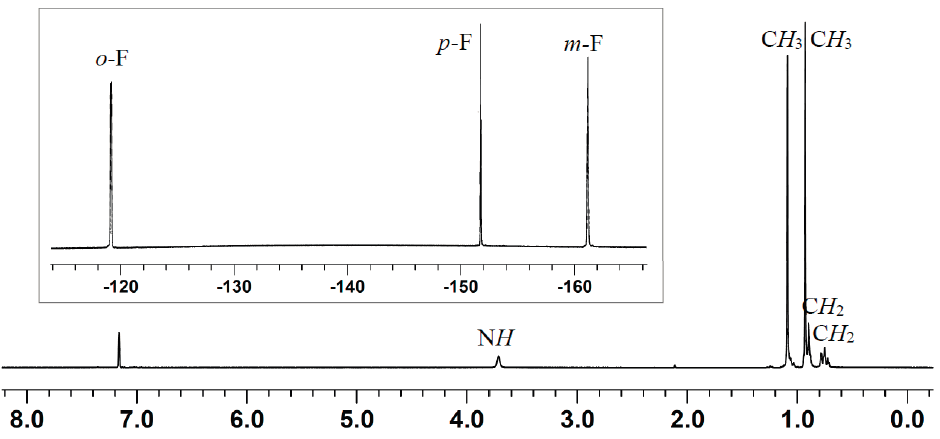
Figure 2. 1 H- and 19 F- (inset) spectra (C 6 D 6 ) of adduct TMP · Al(C 6 F 5 ) 3